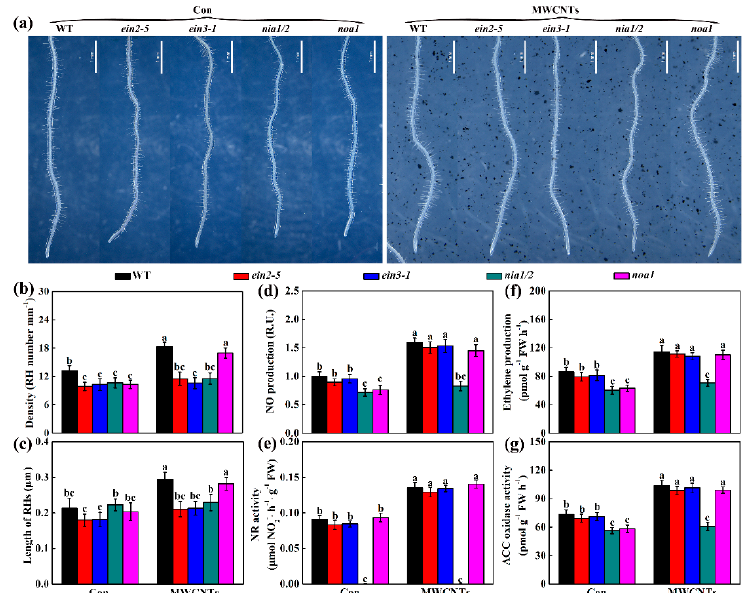
Figure 6. The involvement of NO and ethylene in MWCNTs-triggered root hair development in Arabidopsis . Five-day-old WT, ein2-5 , ein3-1 , nia1/2 , and noa1 mutant plants were grown on MS medium for 5 d and then transplanted to a medium with or without 10 mg/L MWCNTs. After treatments for 5 d, corresponding photographs ( a ), the root hair (RH) density ( b ), and length ( c ) were provided and determined. NO content ( d ), NR activity ( e ), ethylene content ( f ), and ACC oxidase activity ( g ) were also detected after treatments for 3 days. Bars with different letters are significantly different at p < 0.05, according to Duncan’s multiple range test.